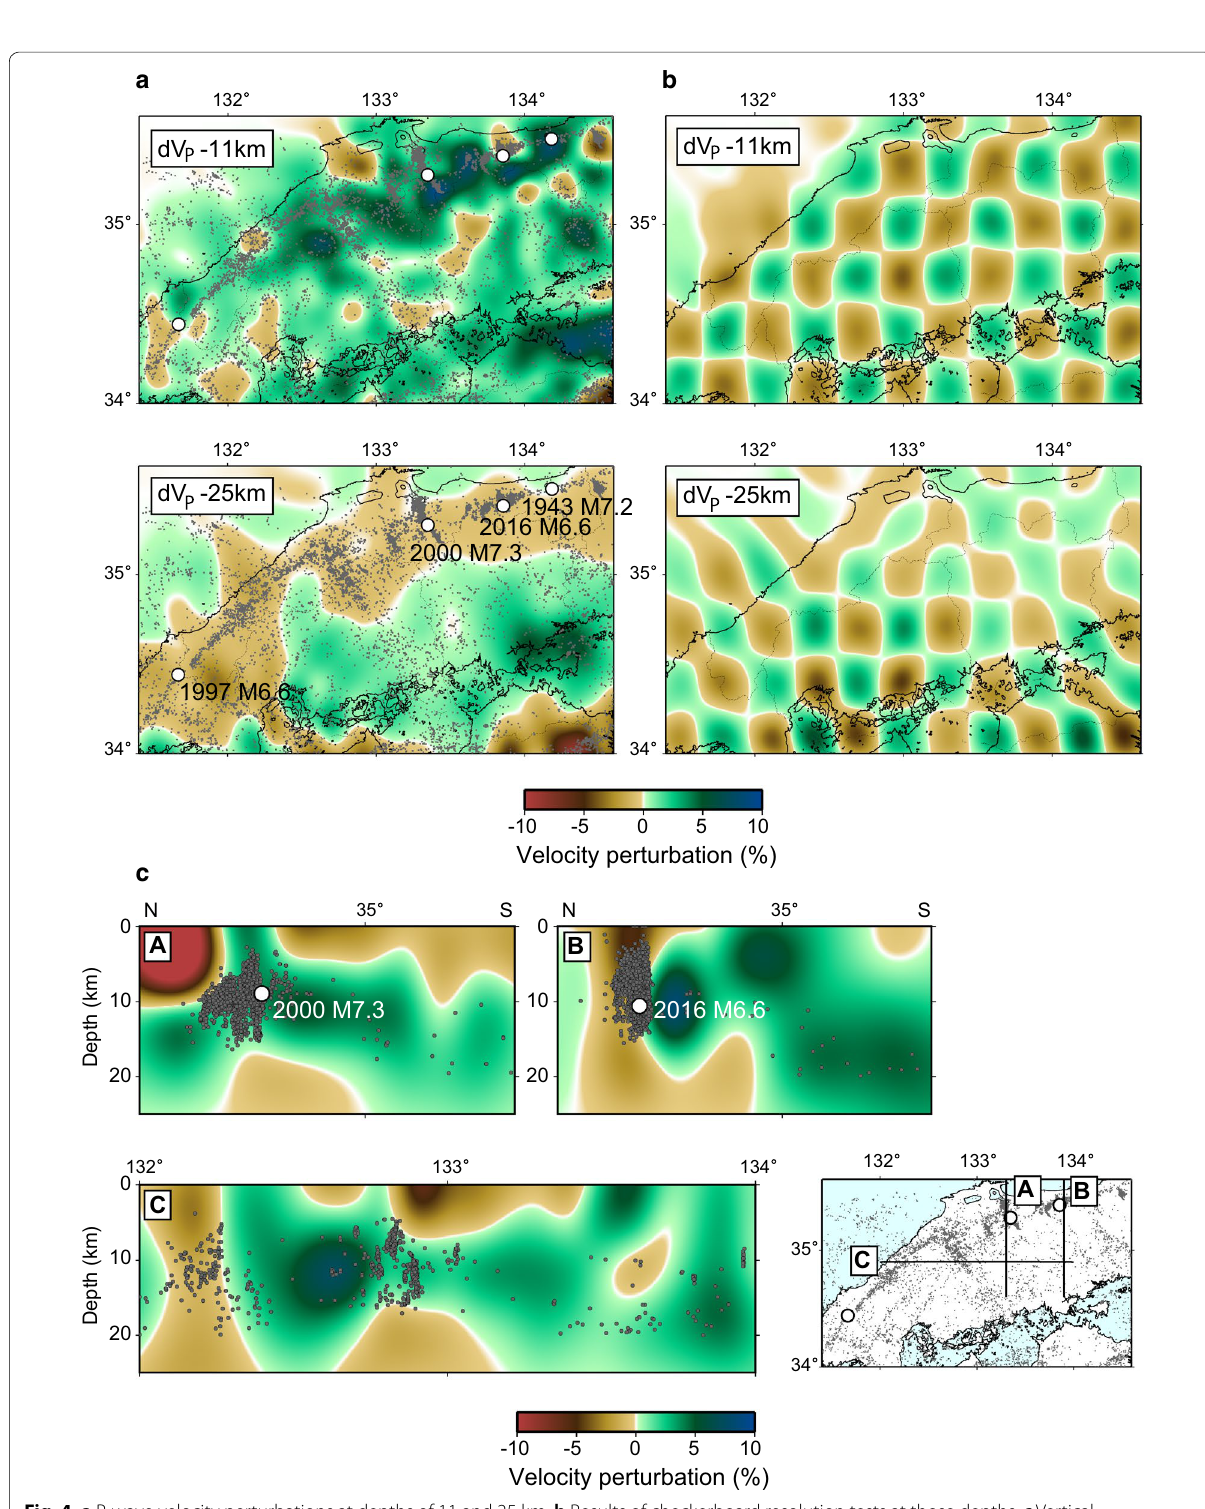
Fig. 4 a P-wave velocity perturbations at depths of 11 and 25 km. b Results of checkerboard resolution tests at those depths. c Vertical cross-sections along lines A–C drawn in the bottom right map. Velocity perturbations are deviations from the initial velocities at each depth. In a and c , gray dots denote earthquakes of M J 1.0 and depths 20 km that occurred between January 2001 and December 2016. White circles ≥ ≤ denote large intraplate earthquakes of M J 6.5 that occurred over the past 100 ≥